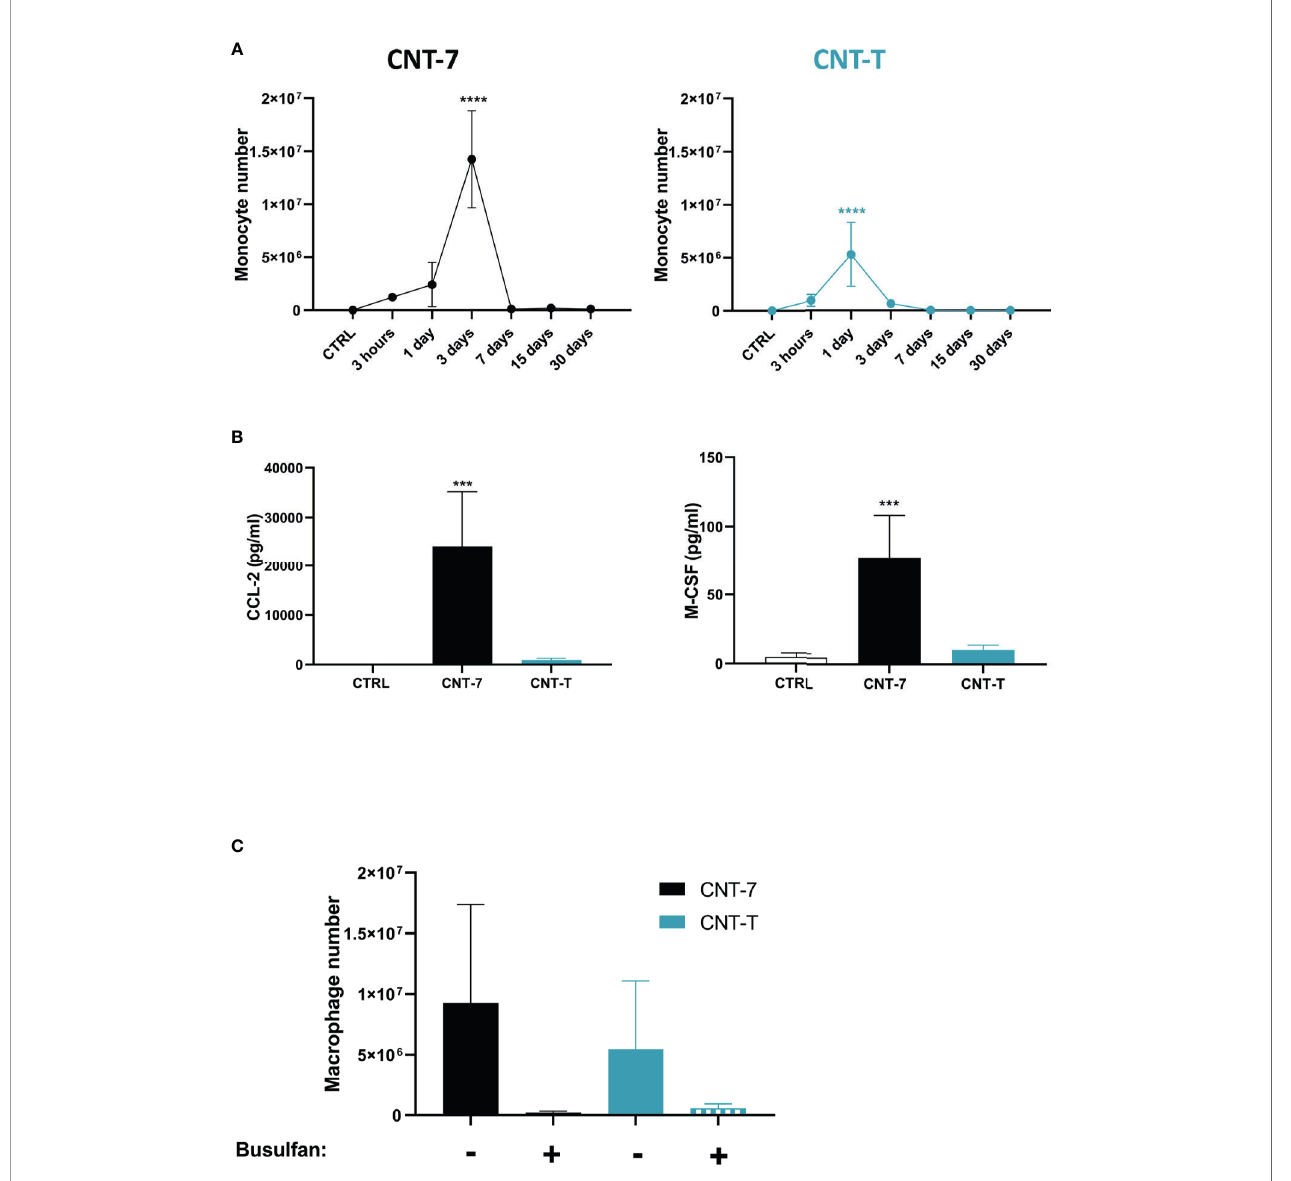
FIGURE 4 | Macrophage regeneration after CNT-7 treatment depends on blood monocytes. (A) Number of peritoneal monocytes in response to mesotheliomagenic CNT-7 and non-mesotheliomagenic CNT-T (2 mg, I.P.) (day 0-30). CTRL are untreated rats sacri fi ced at 3 hours. Each point represents the mean of 4 samples ± SD. (B) CCL2 and M-CSF released at 3 hours in untreated and CNT-7 and CNT-T-treated rat (2 mg, I.P.) peritoneal fl uid were tested using Bio-Plex multiplex assay. M-CSF and CCL2 were found to be abundantly produced by CNT-7-treated rats. (C) Percentage of peritoneal macrophages (CD11bc high HIS48 dim ) after S.C. injection of double dose of Busulfan (15 mg/kg) before and after injection of CNT-7 and CNT-T. Rats were sacri fi ced 15 days after CNT injection. Each bar represents the mean of 3 replicates ± SD. The results were statistically analysed using ANOVA test followed by Dunnett ’ s test. (***) p = 0.0002, (****) p < 0.0001 indicates a statistically signi fi cant difference with